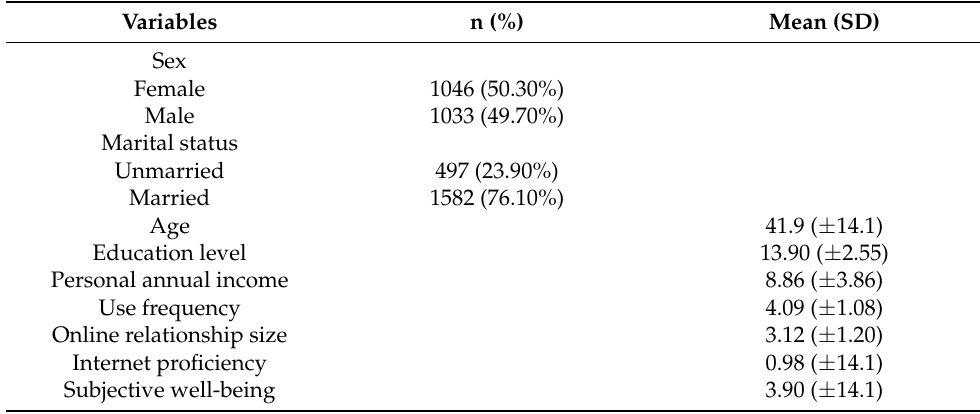
Table 1. Demographics and characteristics of participants (N = 2079).